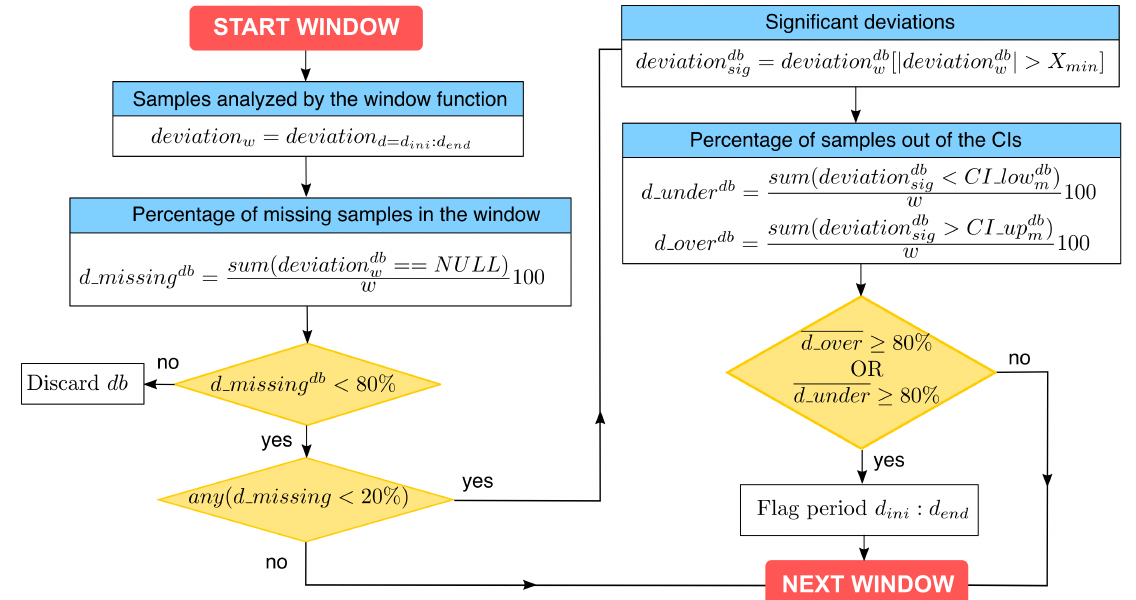
Figure 2. Flowchart of the window function ( db = variable calculated for each radiation database, d = day of the time series, d ini , d end = first and last days of the time series, respectively, CI = confidence intervals of the daily deviations, CI _ low , CI _ up = lower and upper limits of the CI, X variable analyzed, X min minimum value of X to consider the deviations